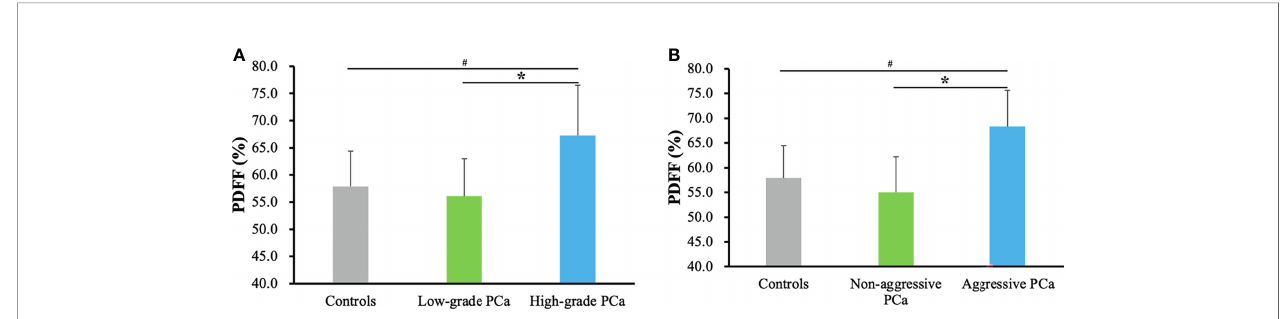
Table 2 gives multivariable-adjusted associations of marrow PDFF with risk of low- and high-grade prostate cancer and